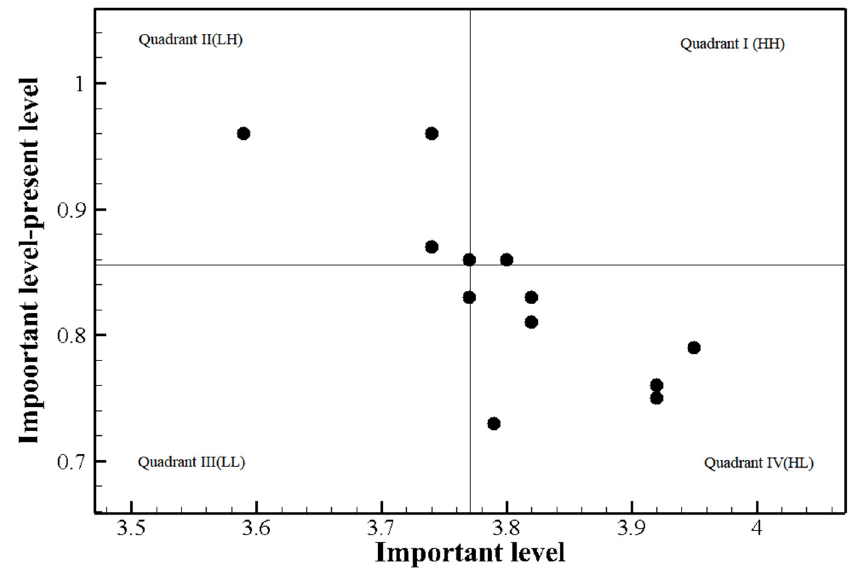
Figure 4. The Locus for Focus model analysis of participants without prior COVID-19 patient care